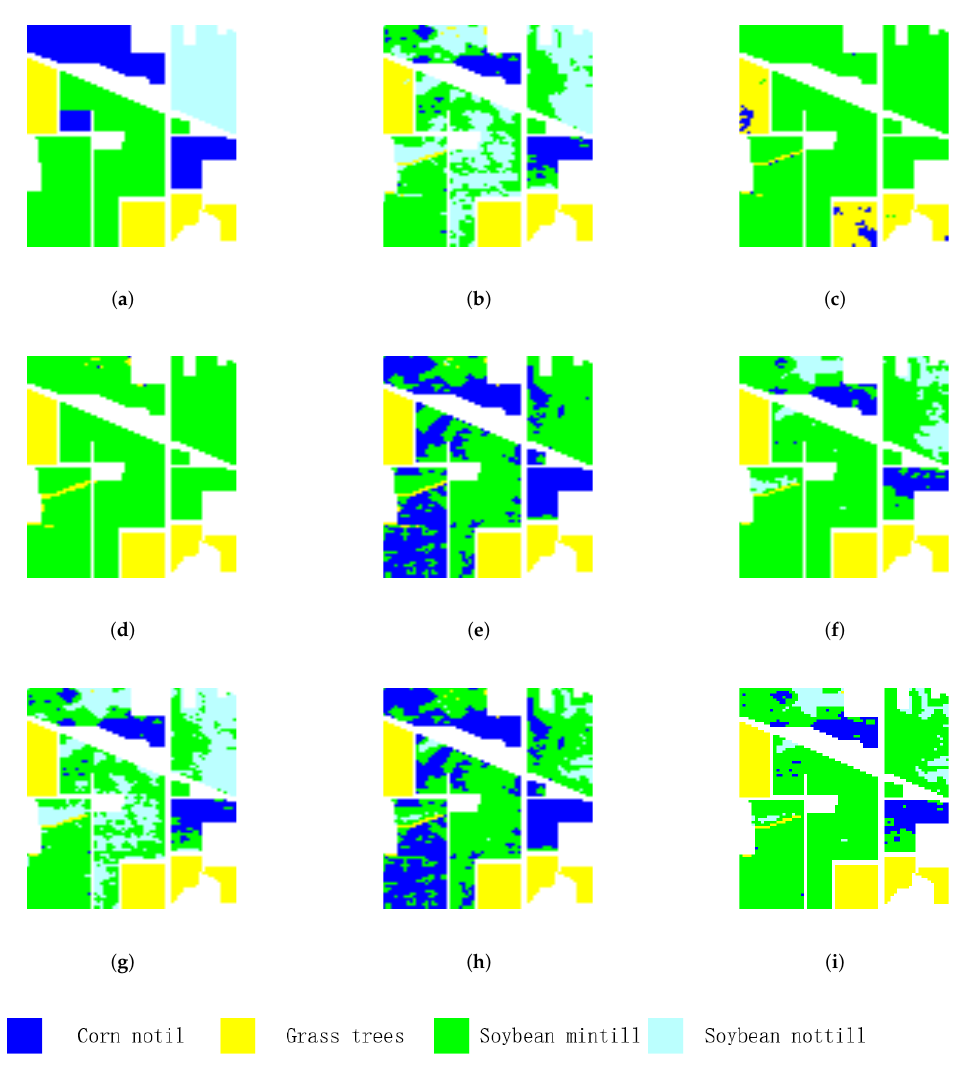
Figure 6. Cluster maps of different methods for the Indian Pines dataset. ( a ) Ground truth, ( b ) NMF,